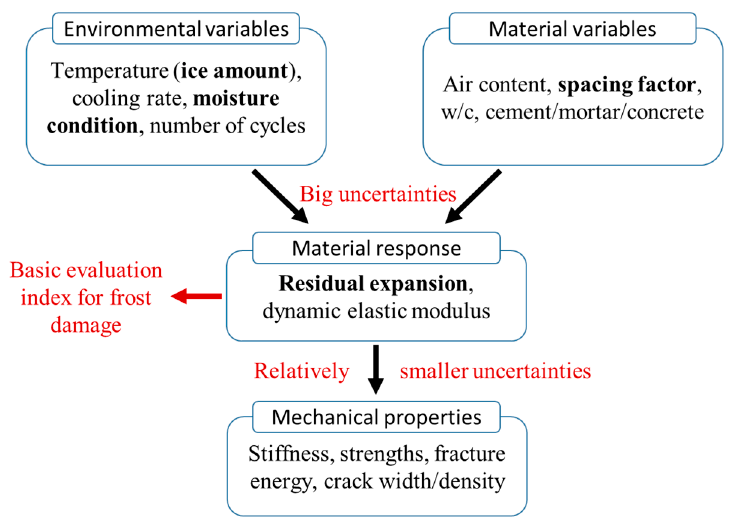
Figure 26. The influential factors, logic scheme, and uncertainties in the frost damage prediction.